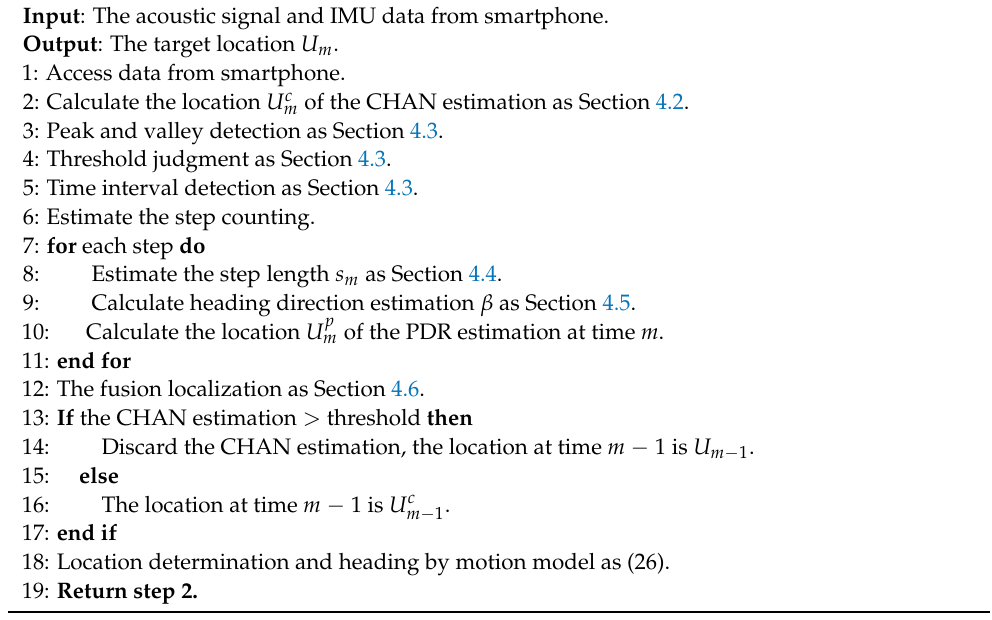
Algorithm 1: Procedure of fusion localization